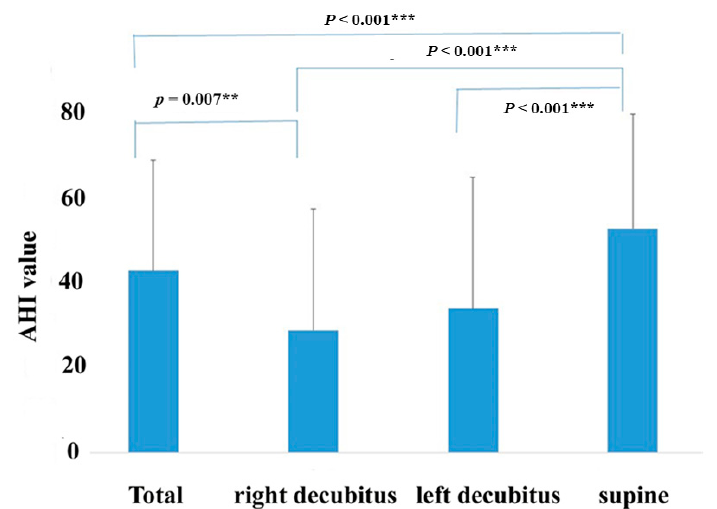
Figure 4. Change of the apnea-hypopnea index (AHI) by body position. The AHI value is shown in total periods, right lateral and left lateral decubitus, and supine position. Correlations between each position are illustrated. p < 0.05 *, p < 0.01 **, and p < 0.001 ***.